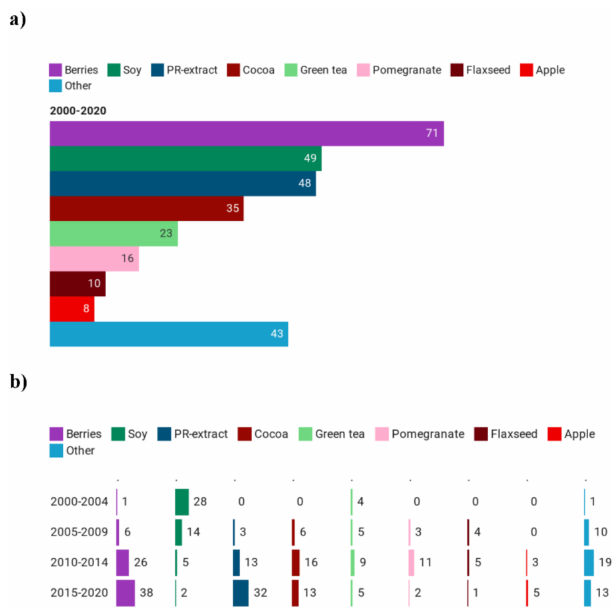
Figure 4. Main polyphenol-rich extracts ( a ) used in clinical trials and their trend ( b ).